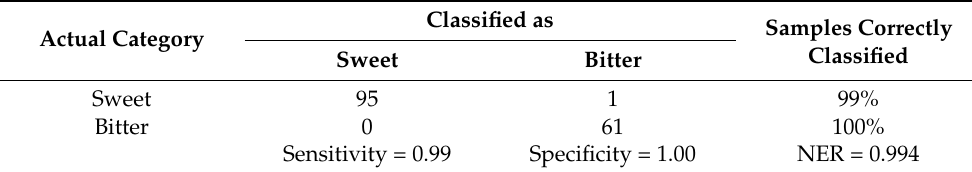
Table 2. Discriminant models for classifying almond batches by bitterness using the most significant wavelengths selected by VIP scores.